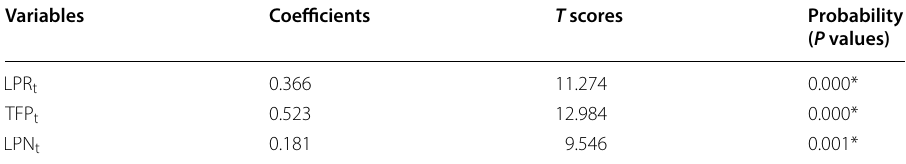
Table 7 Results of normalized long‑run coefficients